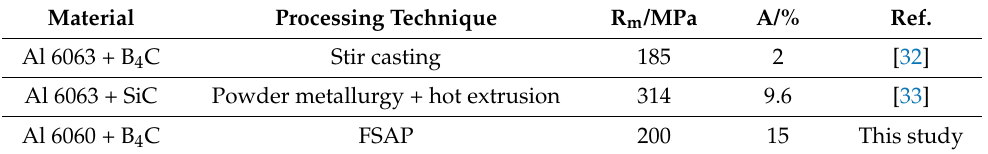
Table 9. Comparison of tensile properties for Al-based MMCs produced by different techniques.